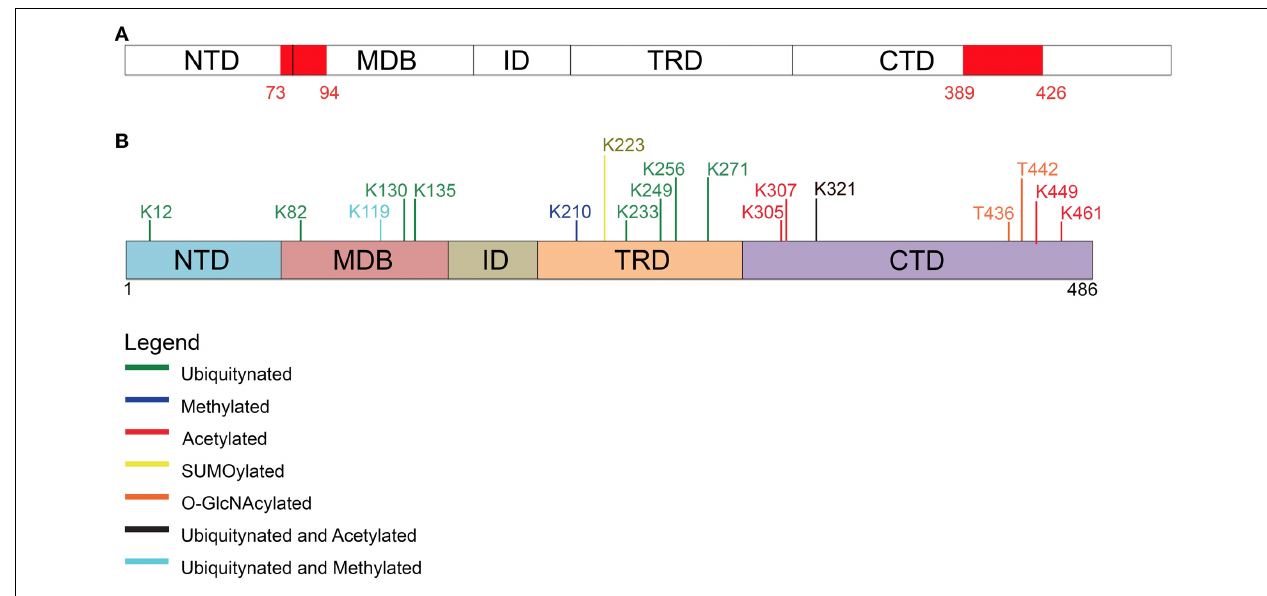
FIGURE 3 | Post-translational modifications other than phosphorylation affecting MeCP2. (A) Two PEST motives, enriched in proline, glutamate, serine, and threonine residues, are present within MeCP2 possibly regulating